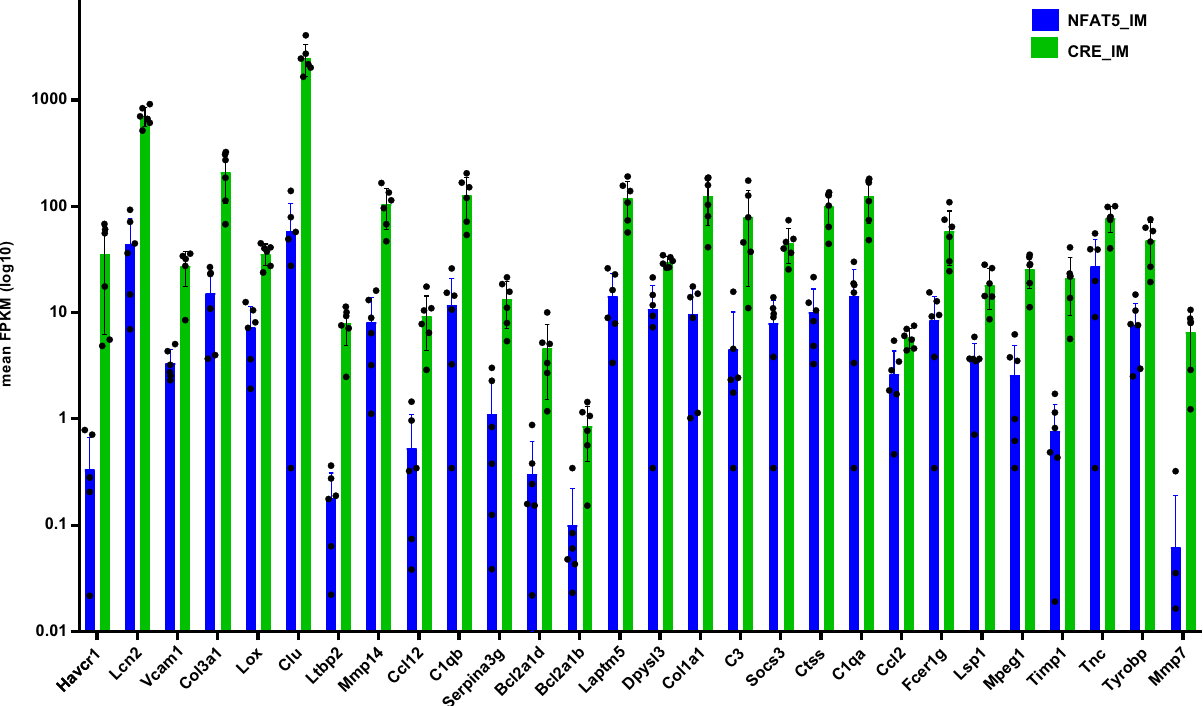
Figure 10. Expression of kidney injury marker genes are increased in NFAT5-KO IM. The expression level (mean FPKM) of well characterized kidney injury marker genes that are differentially expressed between control IM (blue) and NFAT5-KO IM